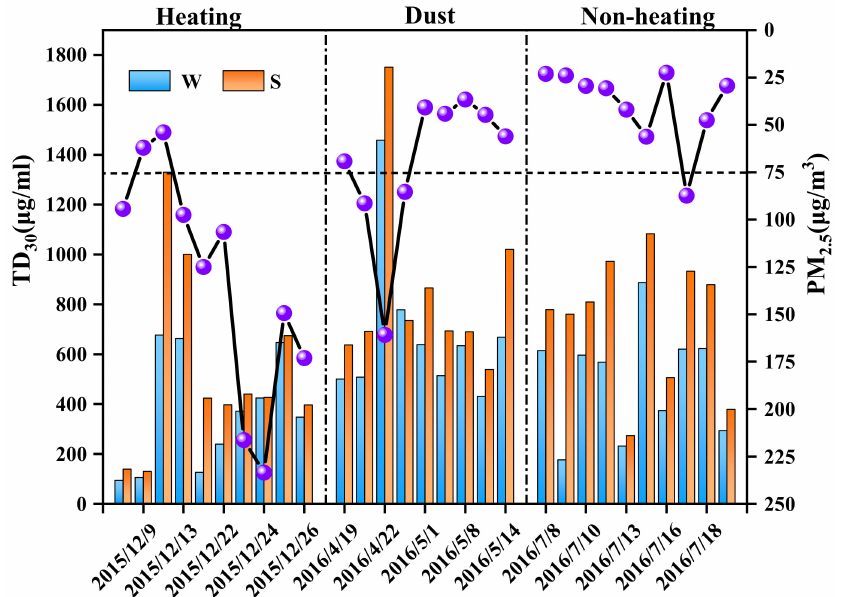
Figure 3. Correlations between the TD 30 values of the whole sample and water-soluble fractions with PM 2.5 mass